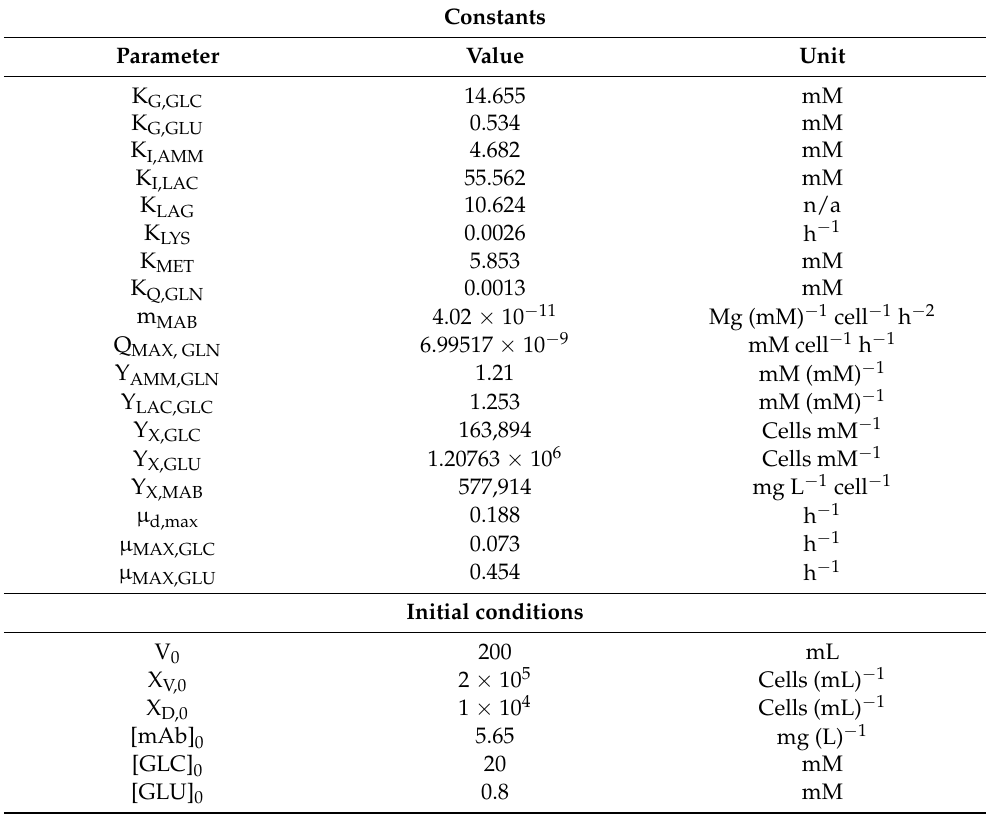
Table 1. The constants and initial conditions used in replicating the results in